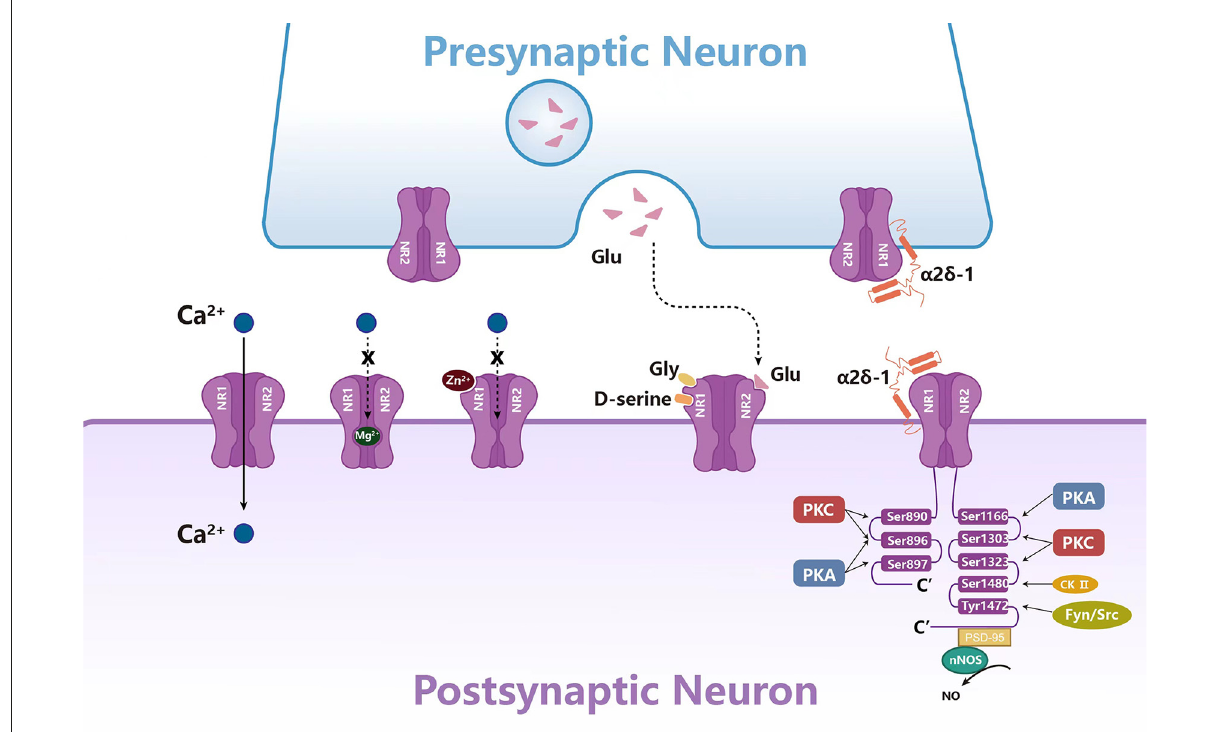
FIGURE2 Molecules in NMDAR regulation in the synaptic transmission. The activity of NMDARs is regulated by a variety of ions, amino acid neurotransmitters, protein kinases, and scaffold proteins. Mg 2+ and Zn 2+ play an antagonistic role by blocking the channel of NMDARs. Gly, Glu, and D-serine can activate NMDAR together. Protein kinases such as PKC, PKA, CK-II, Fyn, and Src can phosphorylate NR1 or NR2. Scaffold proteins α 2 δ -1 and PSD-95 regulate NMDAR activity by directly binding to